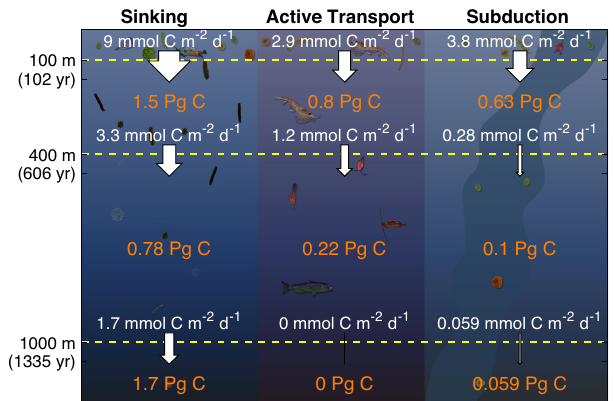
Fig. 4 | Contributions of sinking particles, active transport, and subduction/ vertical mixing to export (white arrows and white text) and carbon seques- tration (orange text) in three depth horizons (100 – 400m, 400 – 1000m, and